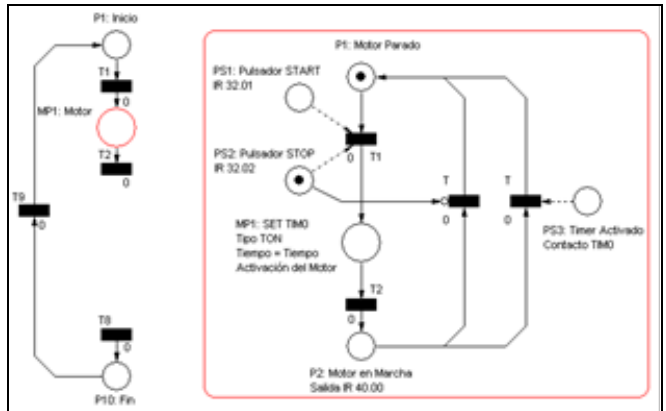
Figura 3: Secuencia de ejecución de GHENeSys IEC-1131 Compatible atendiendo a su nivel jerárquico.